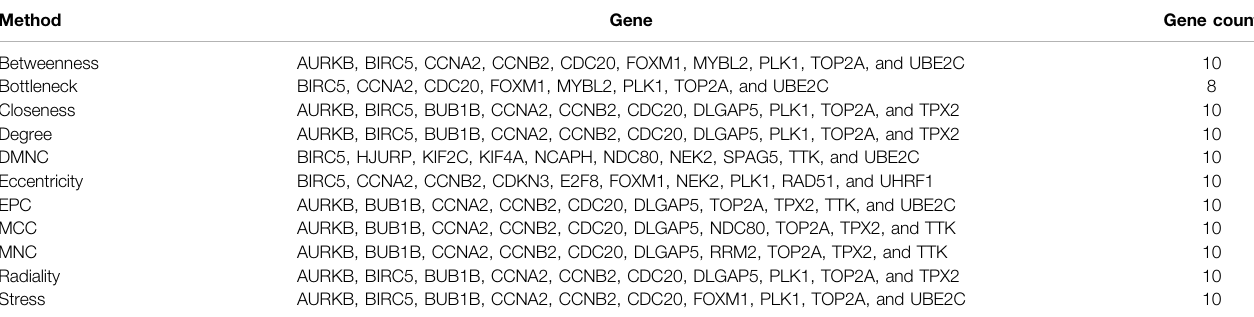
TABLE 2 | Top 10 important genes identi fi ed by different analytical methods.